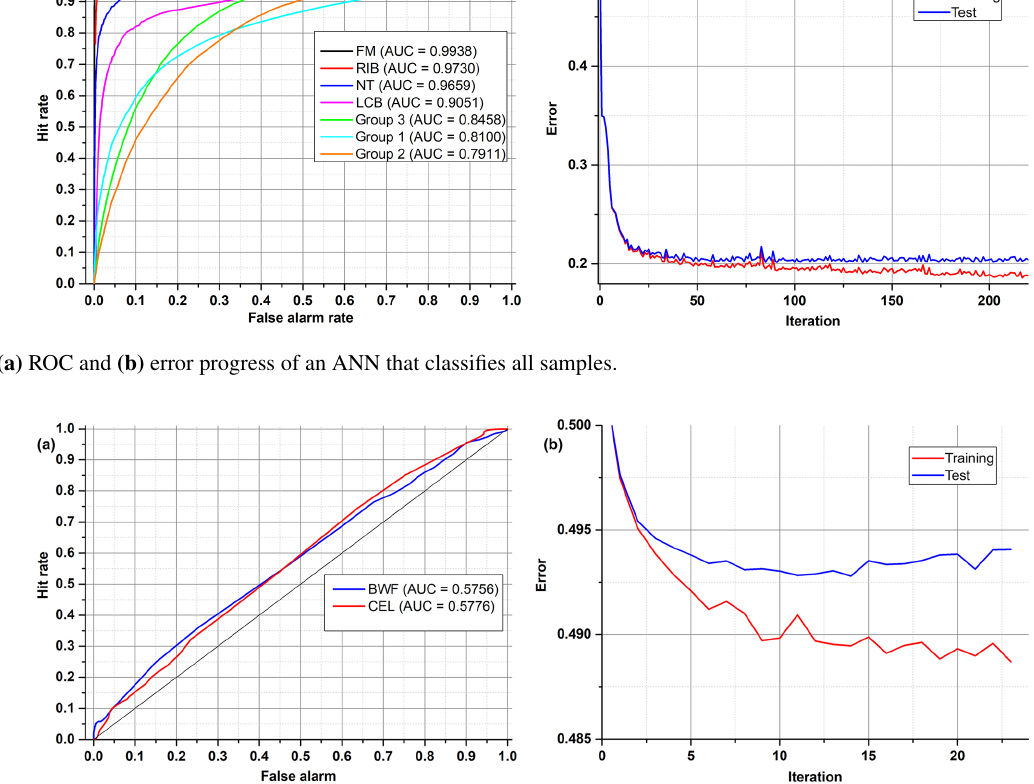
Figure 9. ROC (a) and error progress (b) of an ANN that classifies two very similar